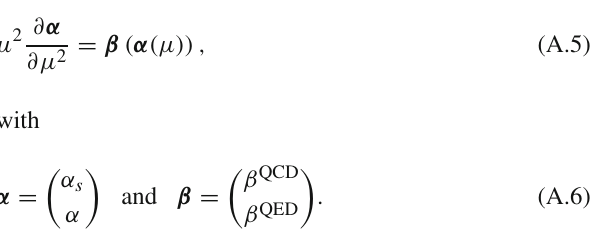
many equations as possible. Such a basis was already intro- duced in Appendix A of Ref. [45] and will be used also